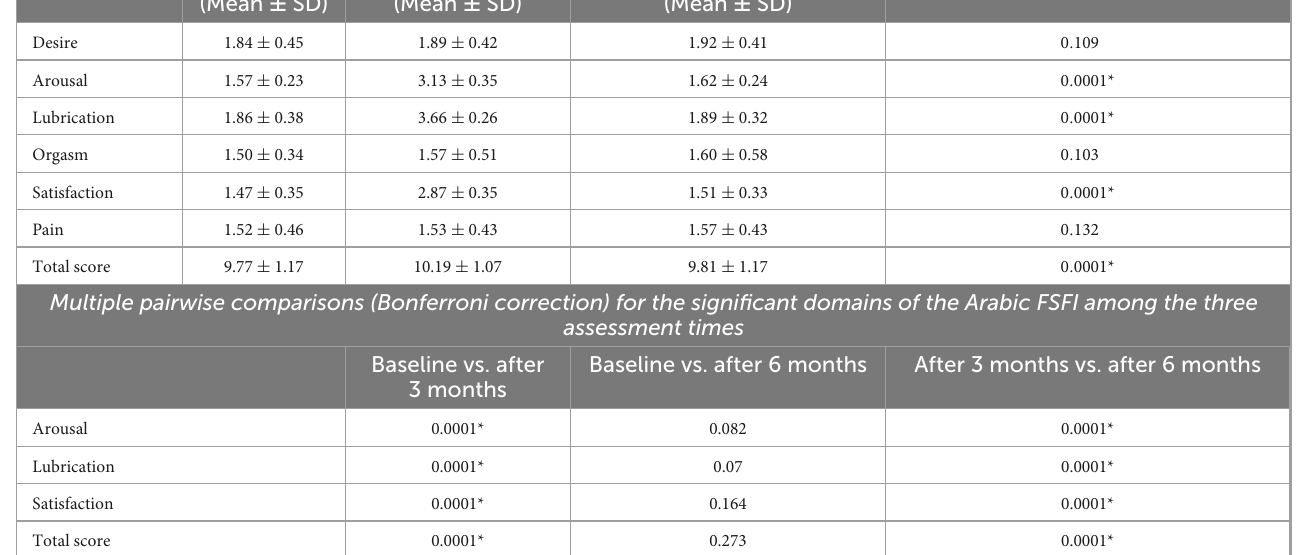
After 6 months (Mean ± SD)